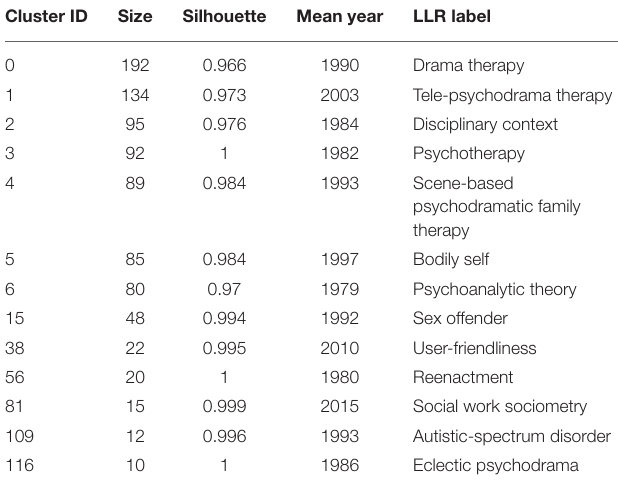
TABLE 2 | Documents with high citation burstness generated by document Co-citation